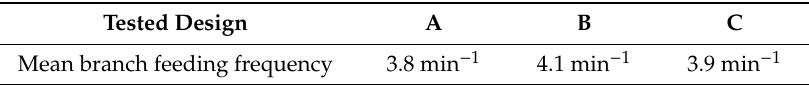
Table 5. Branch feeding frequency in measurement samples, where A: carburettor fuel supply system; B: injector fuel supply system; C: injector fuel supply system equipped with an adaptive drive control system.